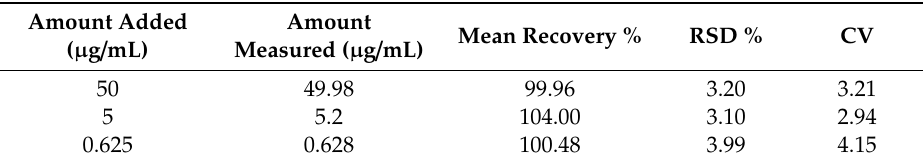
Table 2. Recovery precision and accuracy values for